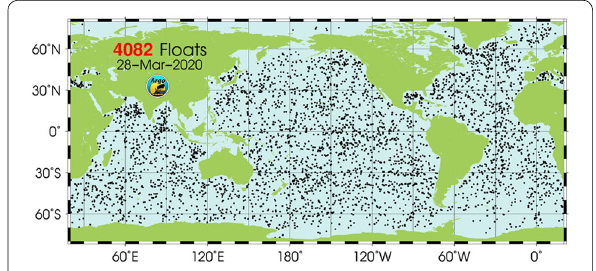
Figure 5 The operational cycle of Argo floats (Figure courtesy from Argo home page: